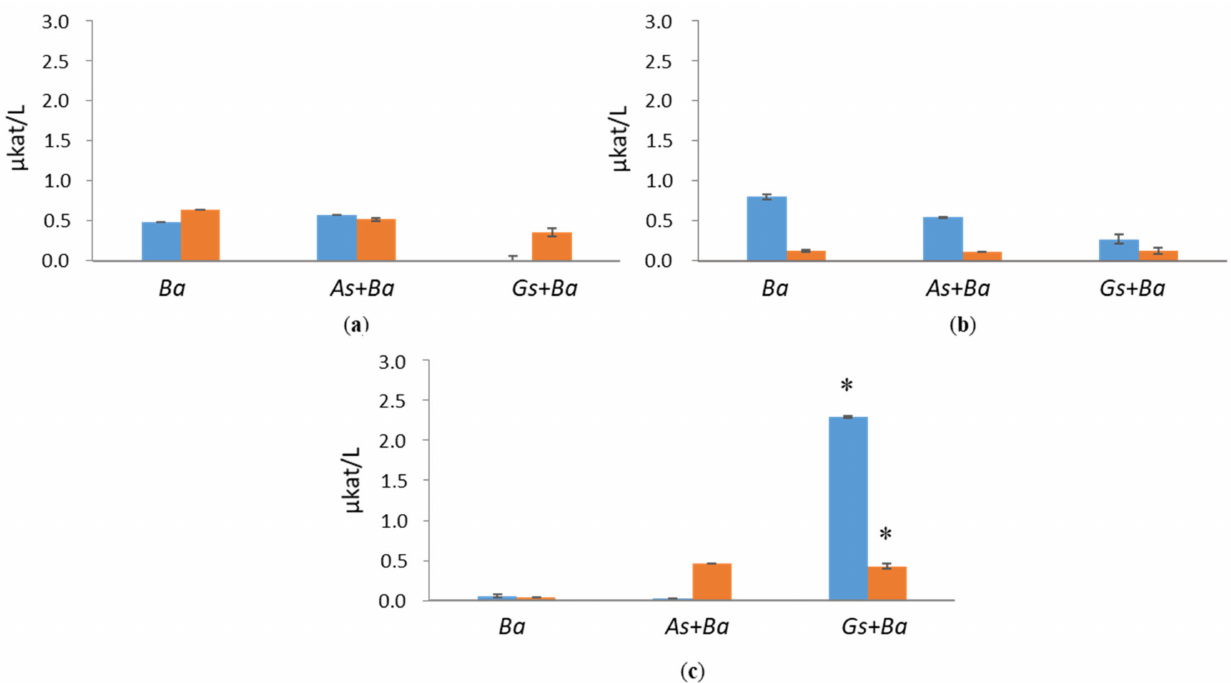
Figure 9. Manganese peroxidase (MnP) activities at early (day 10, marked in blue) and late time points (day 24, marked in red) in single and co-cultivation on ( a ) birch, ( b ) spruce and ( c ) pine wood. Ba = B. adusta , As + Ba = A. sinuosa and B. adusta , Gs+Ba = G. sepiarium and B. adusta . Error bars refer to standard deviation (SD) ( n = 3). * indicates statistical difference among single and co-cultivations ( p < 0.05).